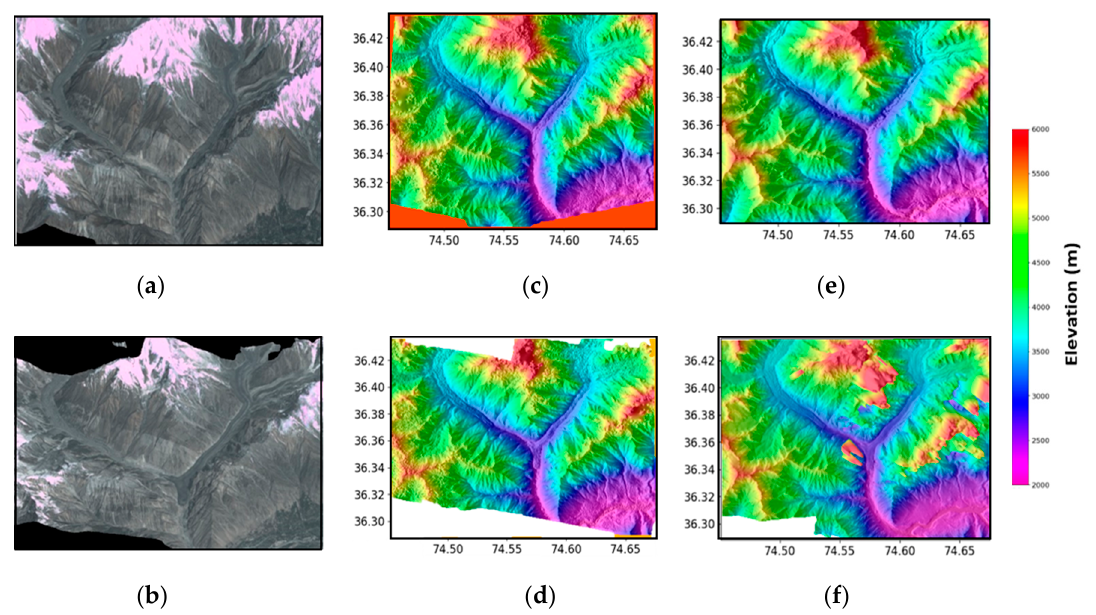
Figure 12. DEMs and textured 3D models over the Shisper area. ( a , b ) Textured 3D models from 2017 ( a ) and 2019 ( b ). ( c , d ) DEMs extracted from PlanetScope data in 2017 ( c ) and 2019 ( d ). ( e ) SRTM DEM. ( f ) DEM generated by combining WV-2 and GE-1 stereo images acquired on 5 July 2019 and on 9 September 2019, respectively.